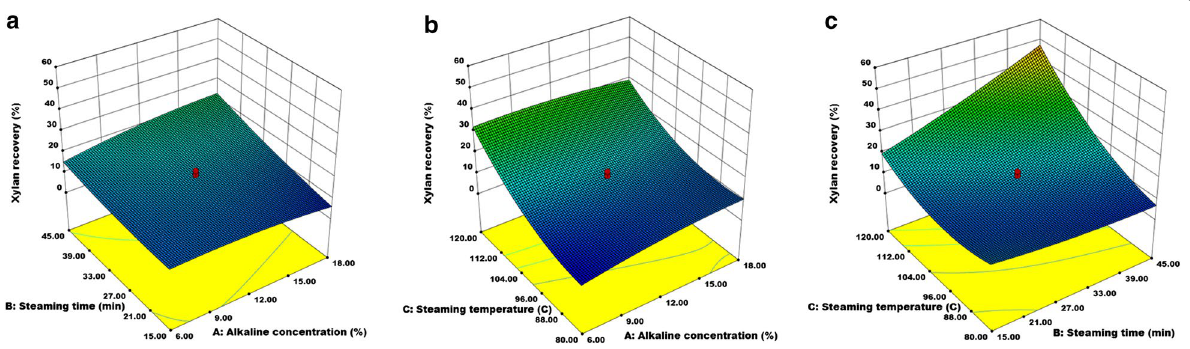
Fig. 1 Response surface plot for alkaline pretreatment of rice husk describing the interaction of independent variables such as alkaline concentration, steaming temperature and steaming time. a Effect of alkaline concentration and streaming time, b effect of alkaline concentration